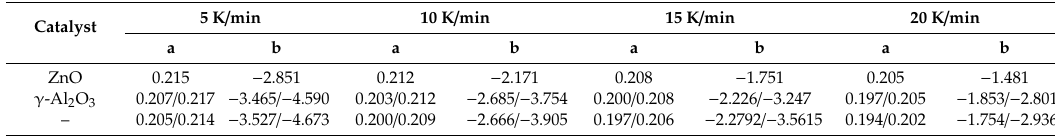
Table 5. Parameters of compensation effect.